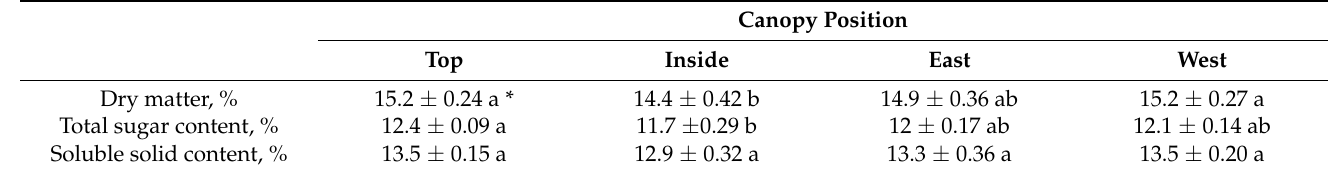
Table 4. Effect of canopy position on fruit chemical content, average 2018–2020.